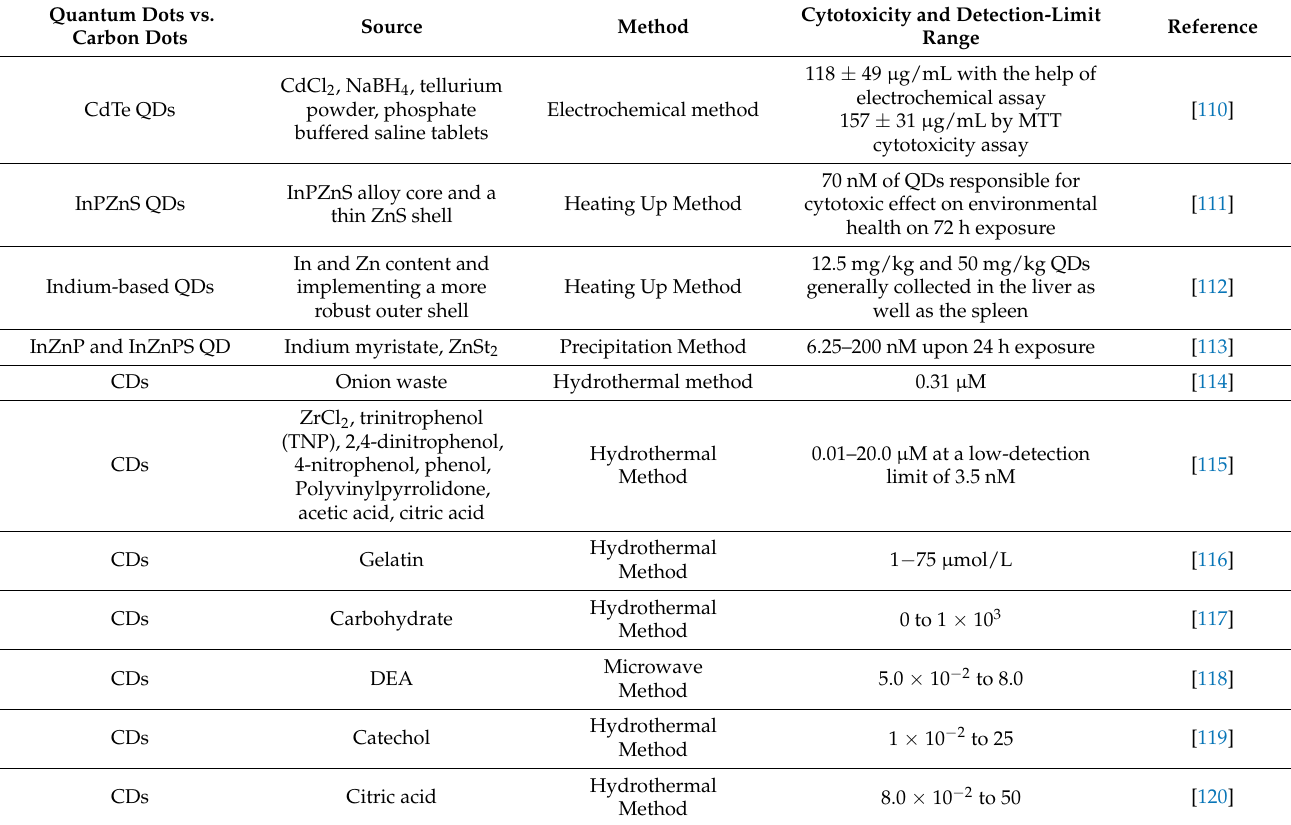
Figure 8. Synthesis of carbon dots from the lemon juice. The CDs were used for deep-tissue imaging, as described in [107]. Table 1. Cytotoxicity and detection-limit range of QDs and